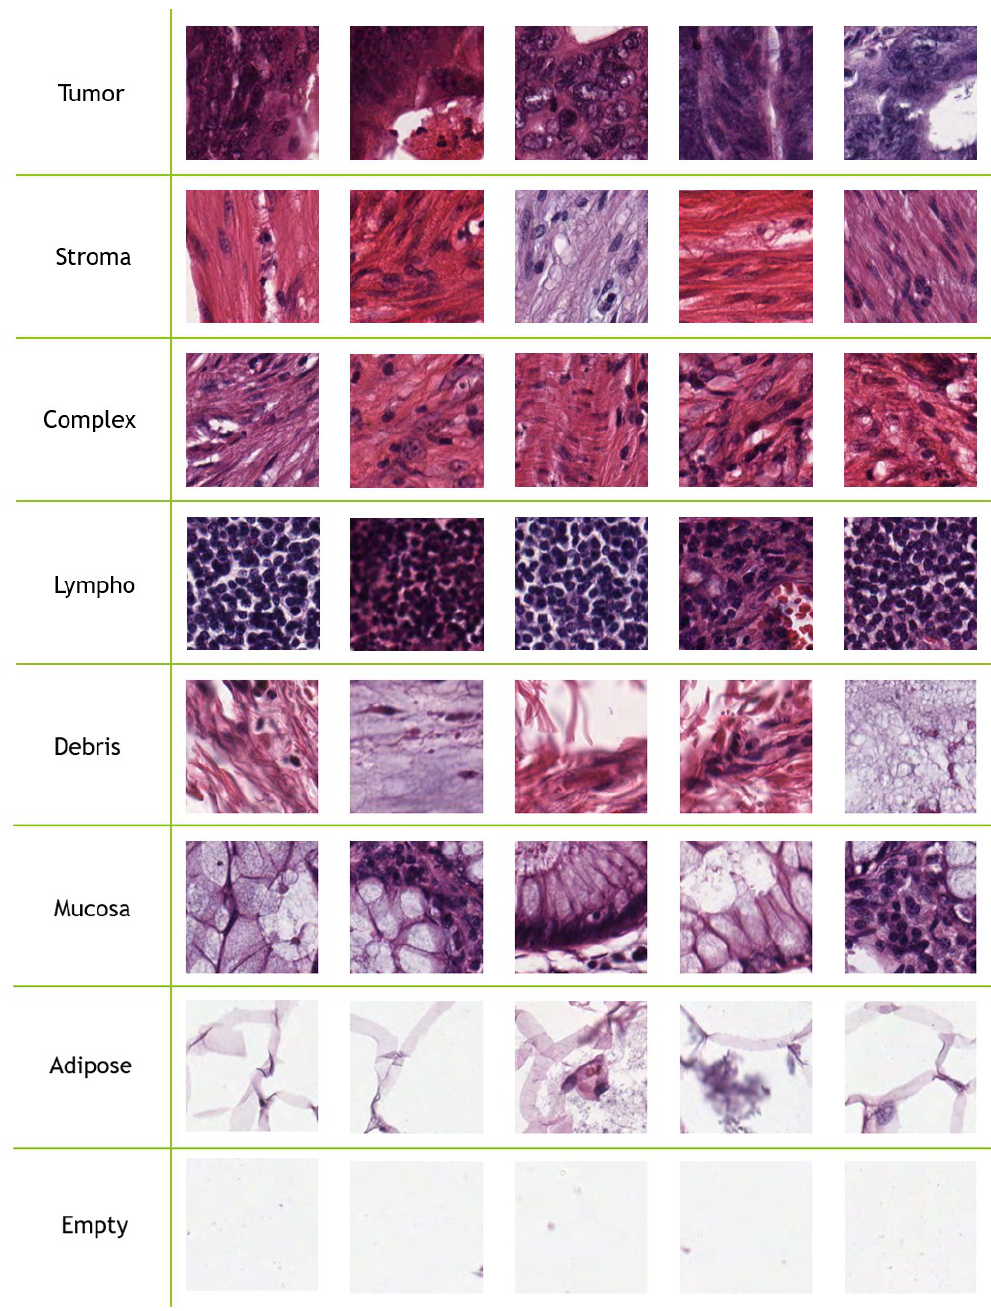
Figure 1. Five samples for each class from the Kather-CRC-2016 database